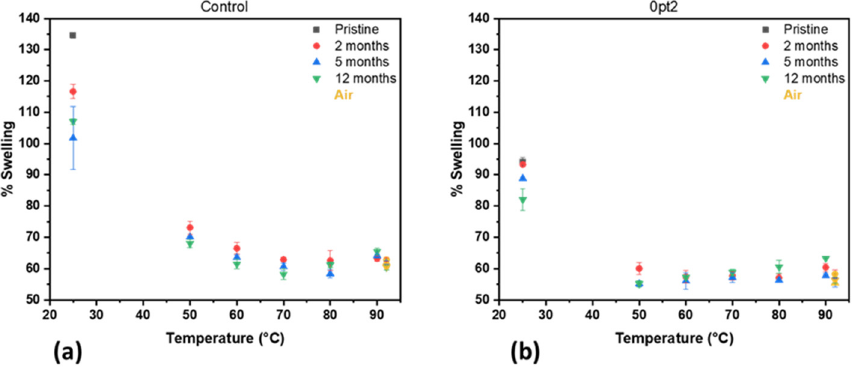
Figure 5. Swelling of thermally aged samples: ( a ) Control and ( b ) 0pt2.